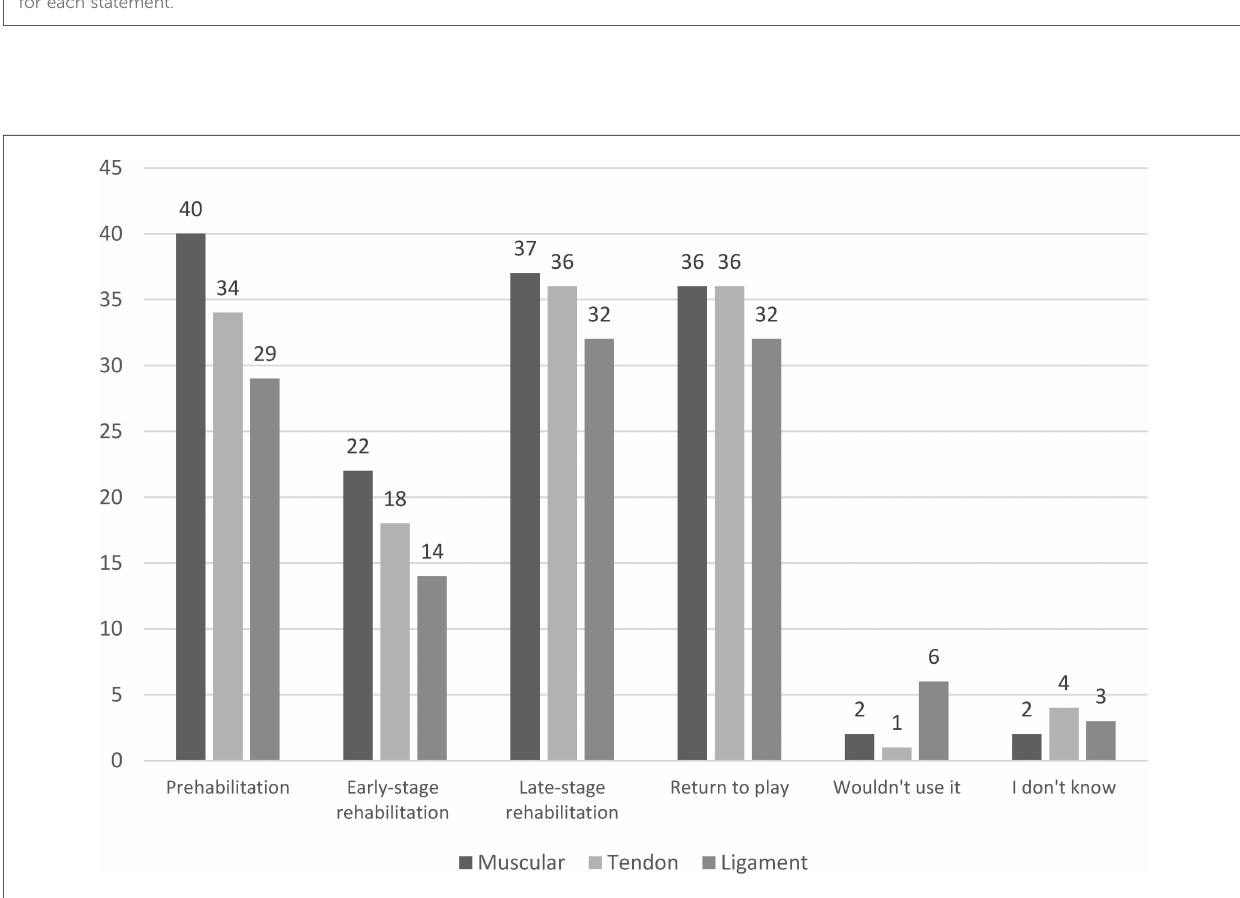
FIGURE 3 The use of fl ywheel training for muscular, tendon, and ligament prehabilitation and rehabilitation amongst therapists working in sport. N